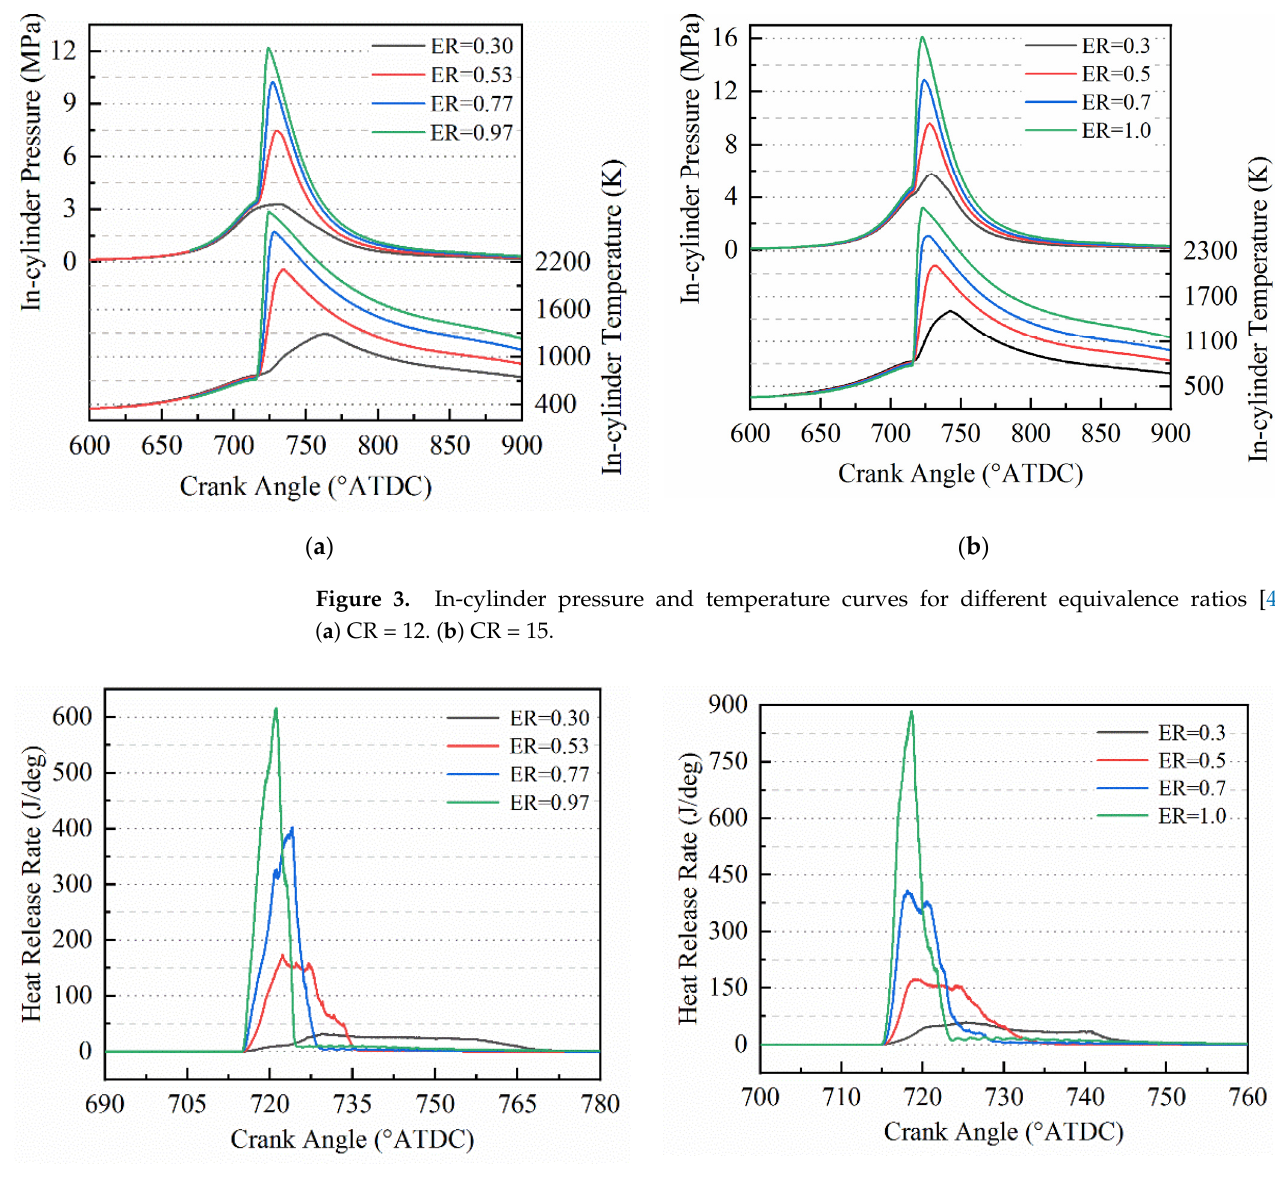
( b ) Figure 2. Ignition delay, combustion duration, and CA50 at different equivalence ratios [48]. ( a ) CR = 12. ( b ) CR = 15. Figures 3 and 4 respectively show the in-cylinder pressure, temperature, and heat- release rate curves for different equivalence ratios and compression ratios. It can be seen that the in-cylinder pressure, temperature, and heat-release rate increased with the increase of the equivalence ratio. Meanwhile, the combustion duration decreased significantly with the increase in the equivalence ratio. For the lean-burn condition with